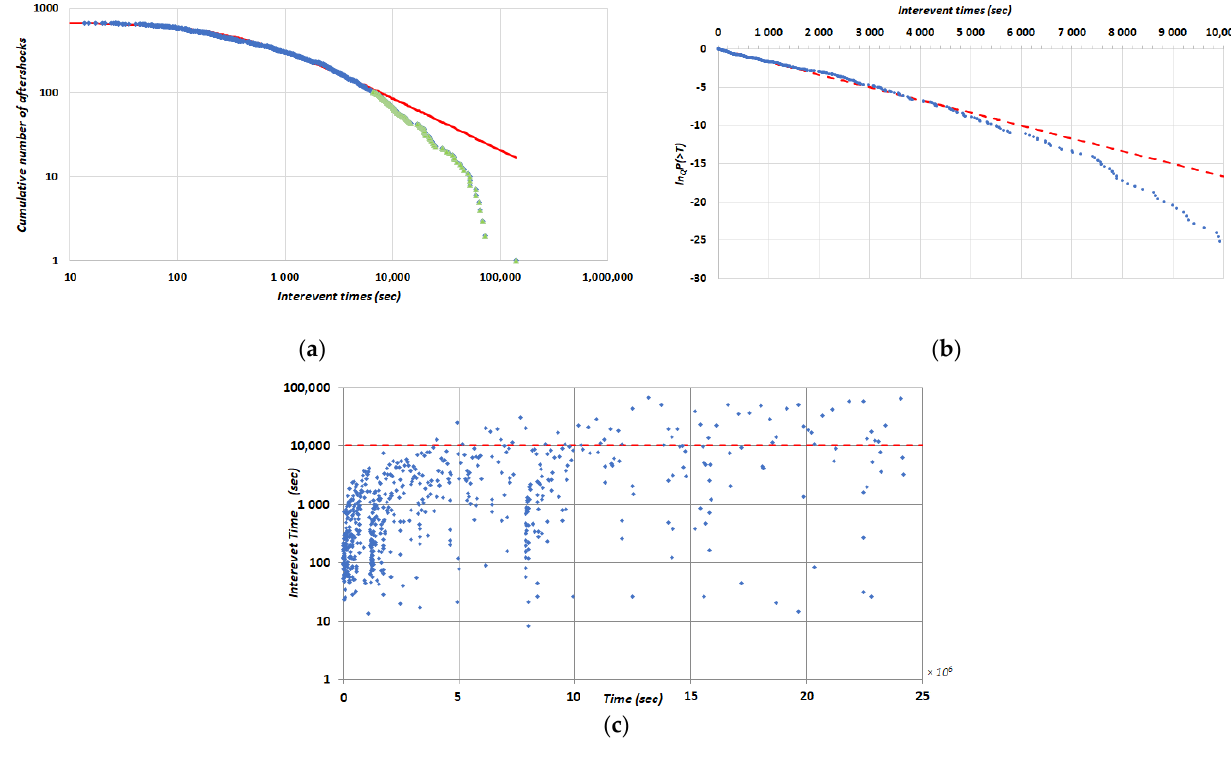
Figure 4. ( a ) The interevent times CDF of the 2021 M w 6.3 Elassona Earthquake, for the aftershocks with M > M c . The scarlet stroke is the Q -exponential fitting with q = 1.62. The change of colors indicates the crossover between the NESP (blue circles) and BG statistics (green triangles). ( b ) The ln Q P (> T ) as a function of T , where the scarlet line presents the fitting with q = 1.62 and correlation coefficient 0.9936 up to T c . T c value close to 4587 s is suggested by the deviation from linearity. ( c ) Interevent time T evolution with time t since the main shock. The red line illustrates the T c value.